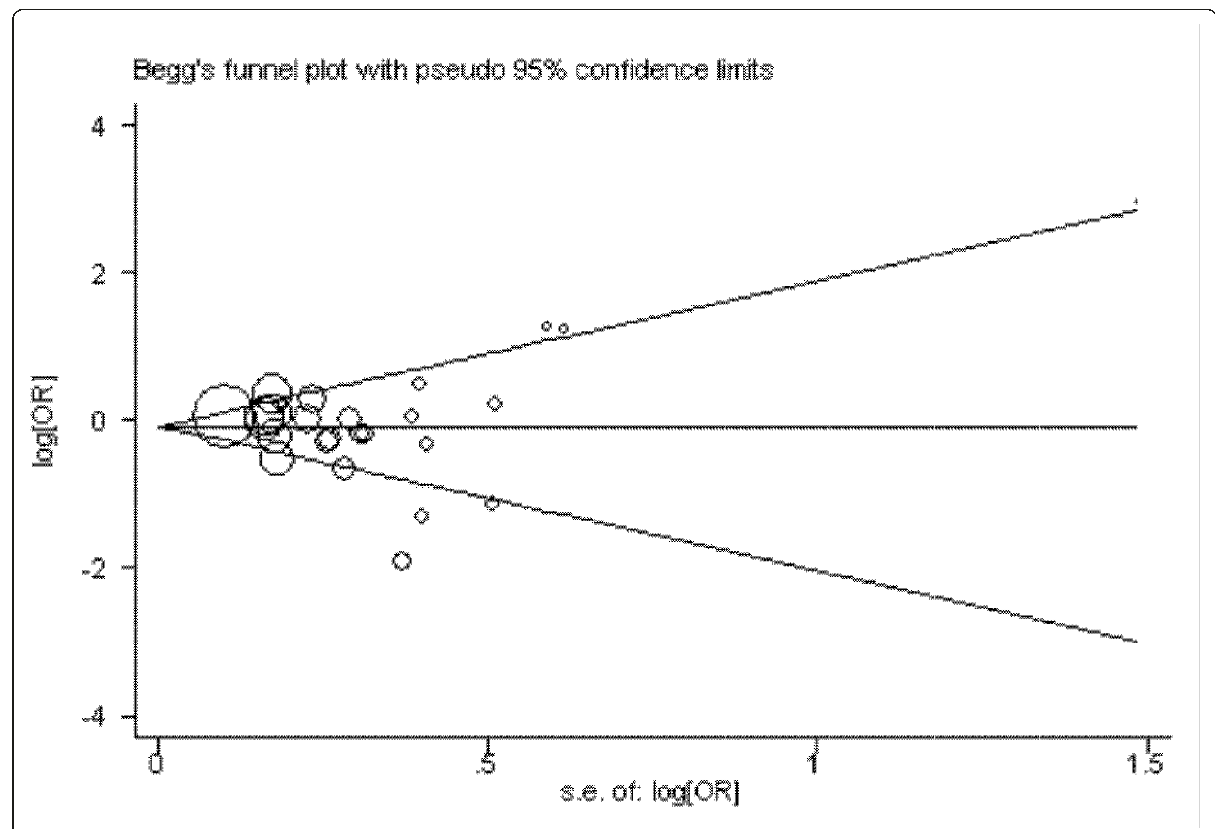
Figure 5 Begg ’ s funnel plot for publication bias in selection of studies on the ACE I/D polymorphism (DD+DI vs II)